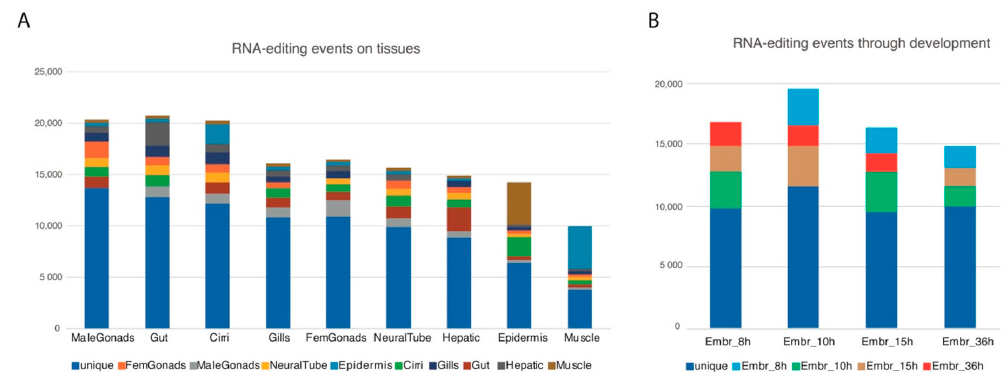
Figure 3. Putative RNA-editing events by tissue and developmental stage. ( A ) Number of putative RNA-editing within coding regions by tissue, specific for one or two of the available tissues. ( B ) Number of putative RNA-editing events within coding loci by developmental stage, specific for one or two of the available